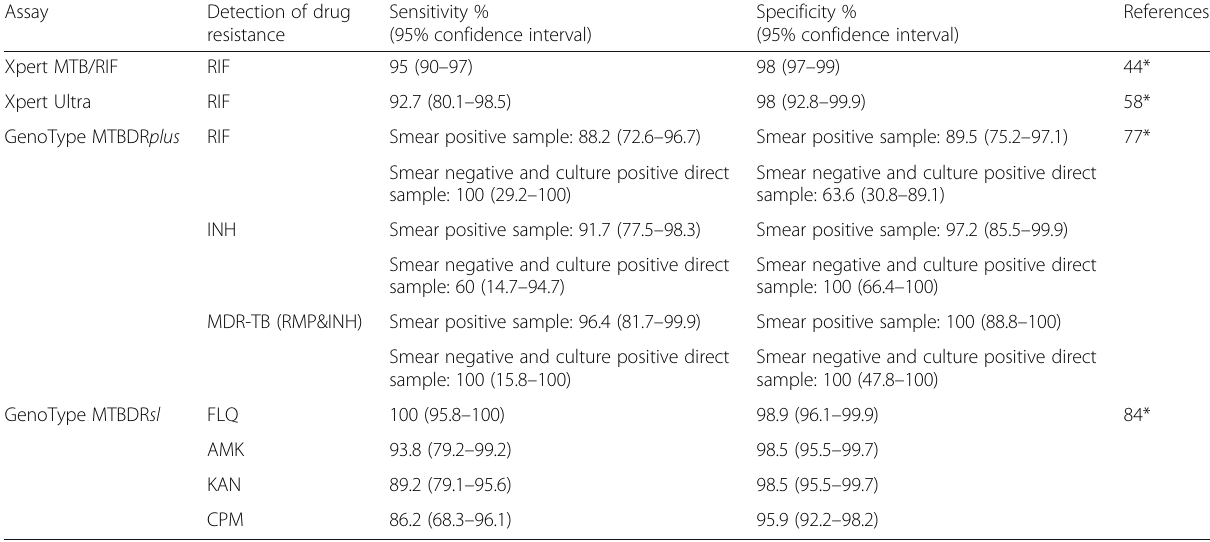
Table 2 Sensitivity and specificity of endorsed molecular assays for rapid detection of drug-resistant TB Assay Detection of drug